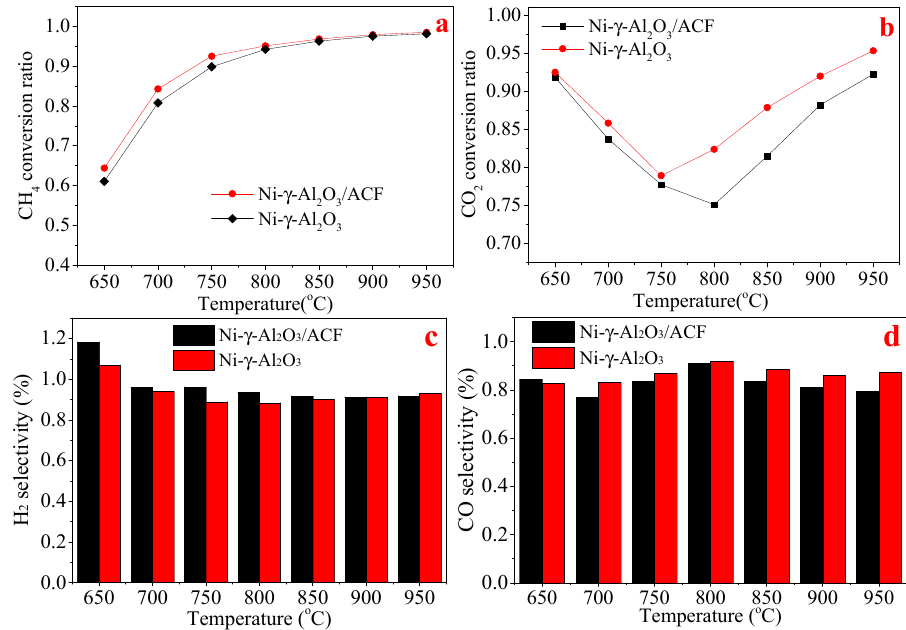
Figure 7. Catalytic activity at different temperatures ( a: CH 4 conversion ratio; b: CO 2 conversion ratio; c: H 2 selectivity; d: CO selectivity ) . GHSV: 24,000 mL·h − 1 ·g − 1 ; detailed reaction conditions: CH 4 : 50 mL/min; CO 2 : 50 mL/min; N 2 : 100 mL/min; catalyst dosage: 0.5 g.